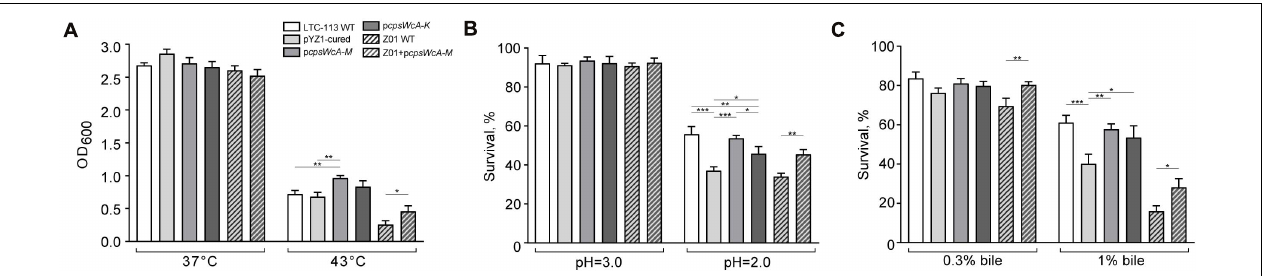
FIGURE 3 | Tolerance of L. plantarum strains to environmental stresses. (A) The comparison of final bacterial density of LTC-113 and its derivative strains at 37 ◦ C and 43 ◦ C after 16-h incubation. (B) The survival rate of LTC-113 and its derivative strains after 2-h treatment at pH = 2.0 and 3.0, respectively. (C) The survival rate of LTC-113 and its derivative strains after 2-h treatment in 0.3 and 1% bile, respectively. Values represent mean ± SD of the mean; * P < 0.05; ** P < 0.01; *** P < 0.001.